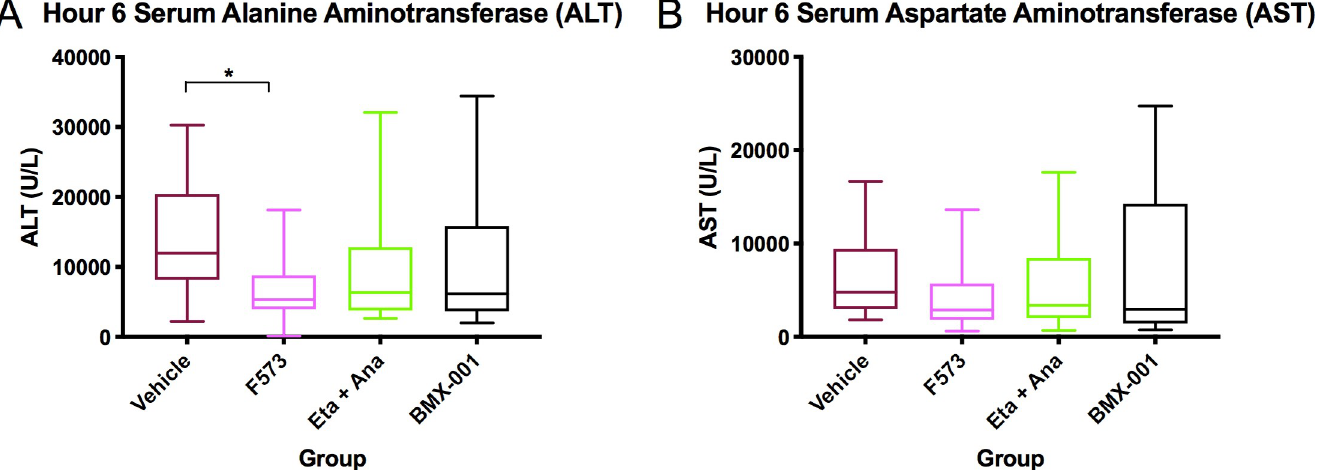
Fig 1. Plasma biochemistry. (A) ALT plasma levels compared to vehicle, with F573 significantly lower (p = 0.01). (B) AST plasma levels compared to vehicle (p = 0.42). Data points show means and SEM, 95% confidence interval (n = 20 per group). Aspartate aminotransferase (AST), Alanine aminotransferase (ALT).